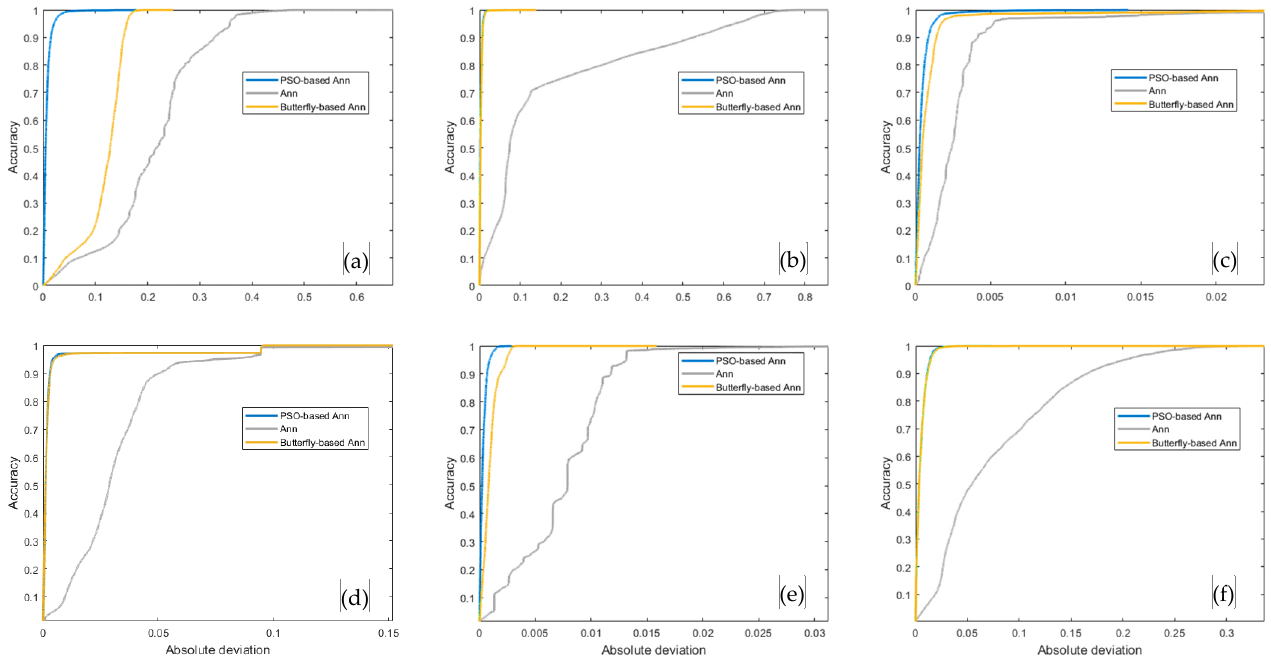
Figure A6. REC curves for ANN-BR, PSO-ANN, and BOA-ANN for ( a ) HWS 1 ( b ) HWS 2 ( c ) HWS